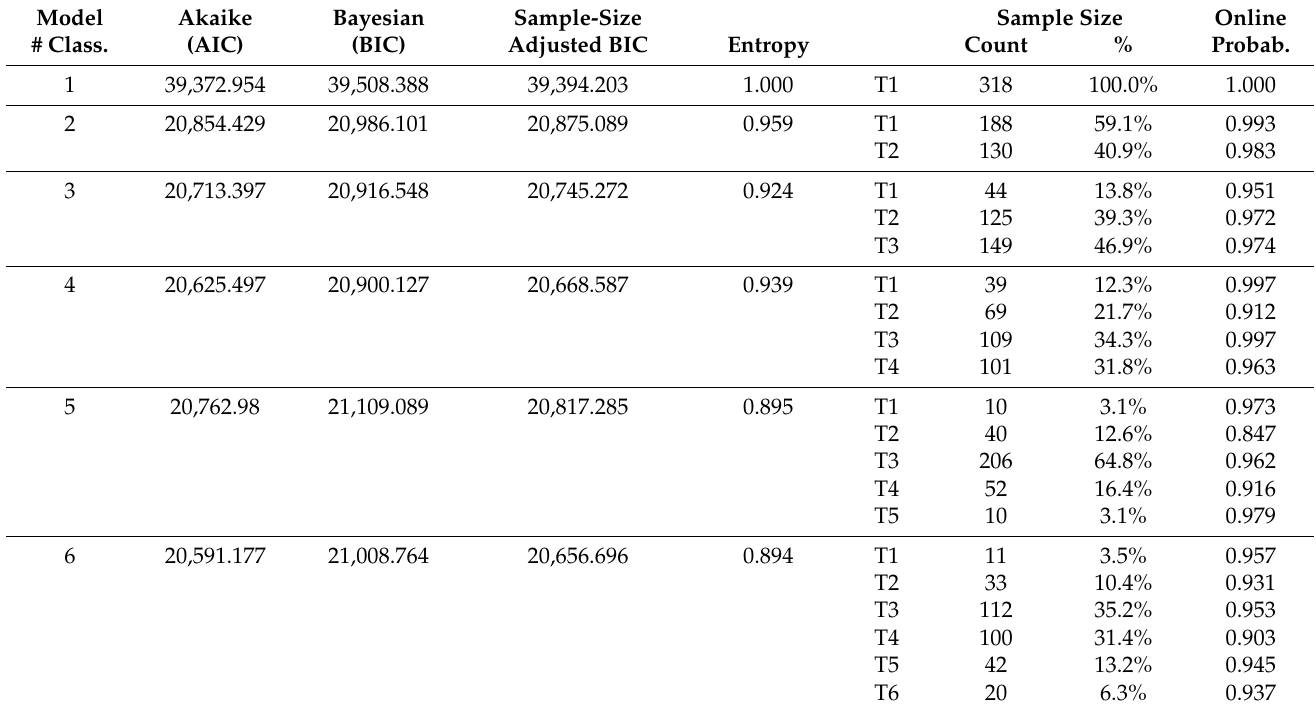
Table 2. Results of the